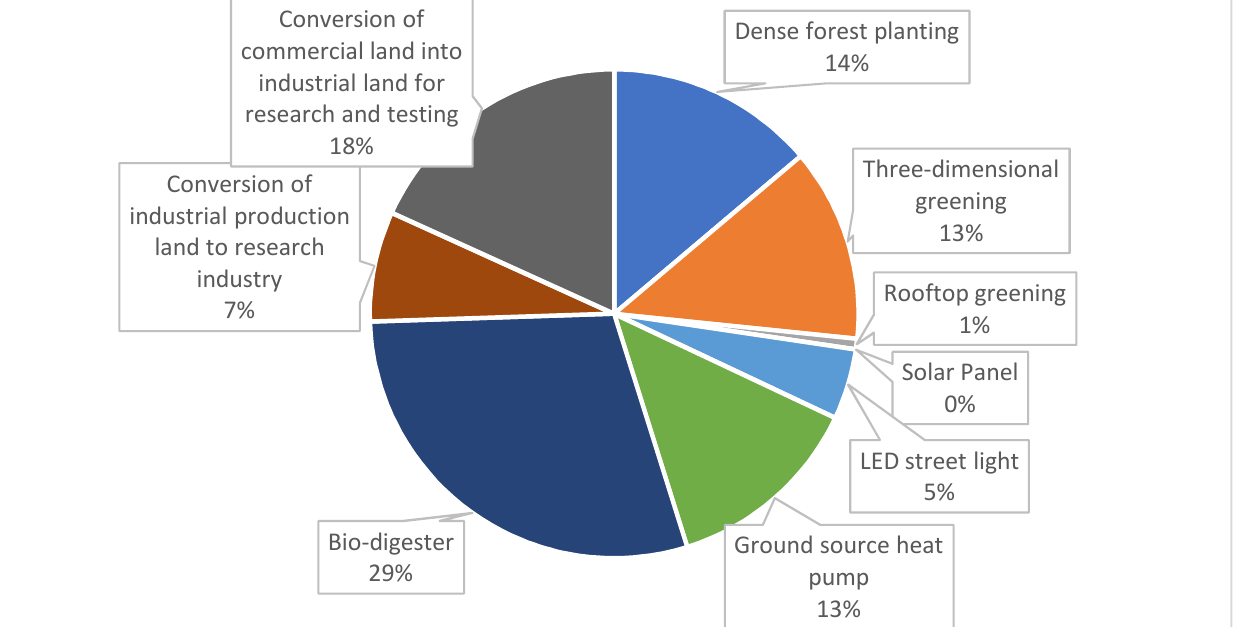
Figure 14. Share of carbon reduction potential for each type of intervention.